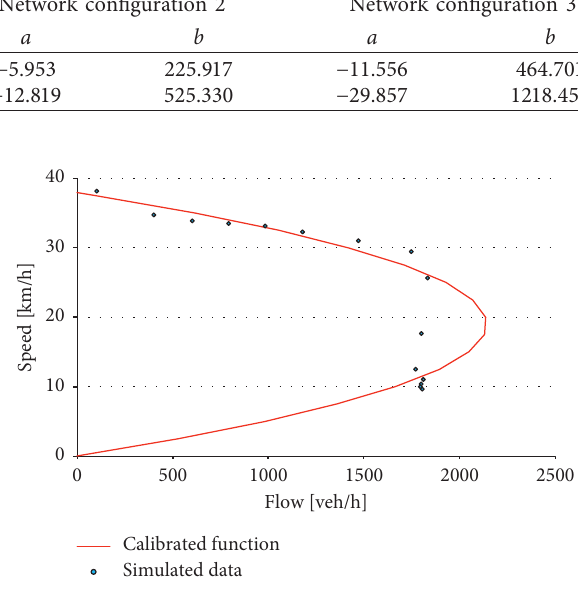
Figure 7: Calibrated function f � f ( v ) in the case of network configuration 2 for the integrated solution.